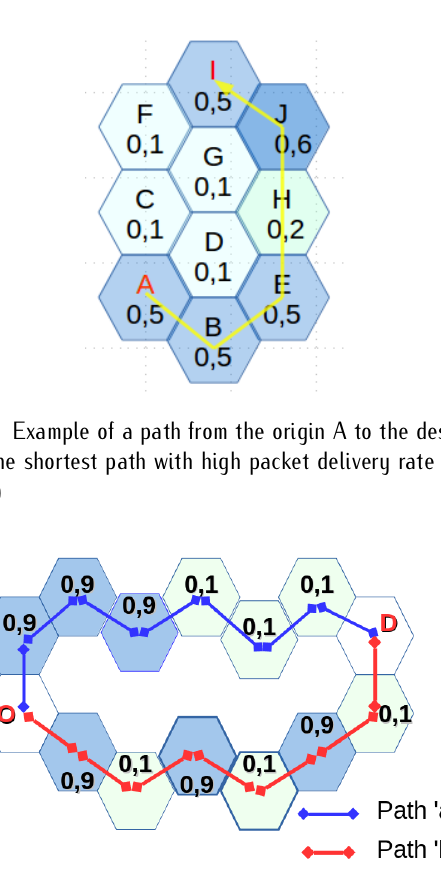
Figure 3. example of paths with the same